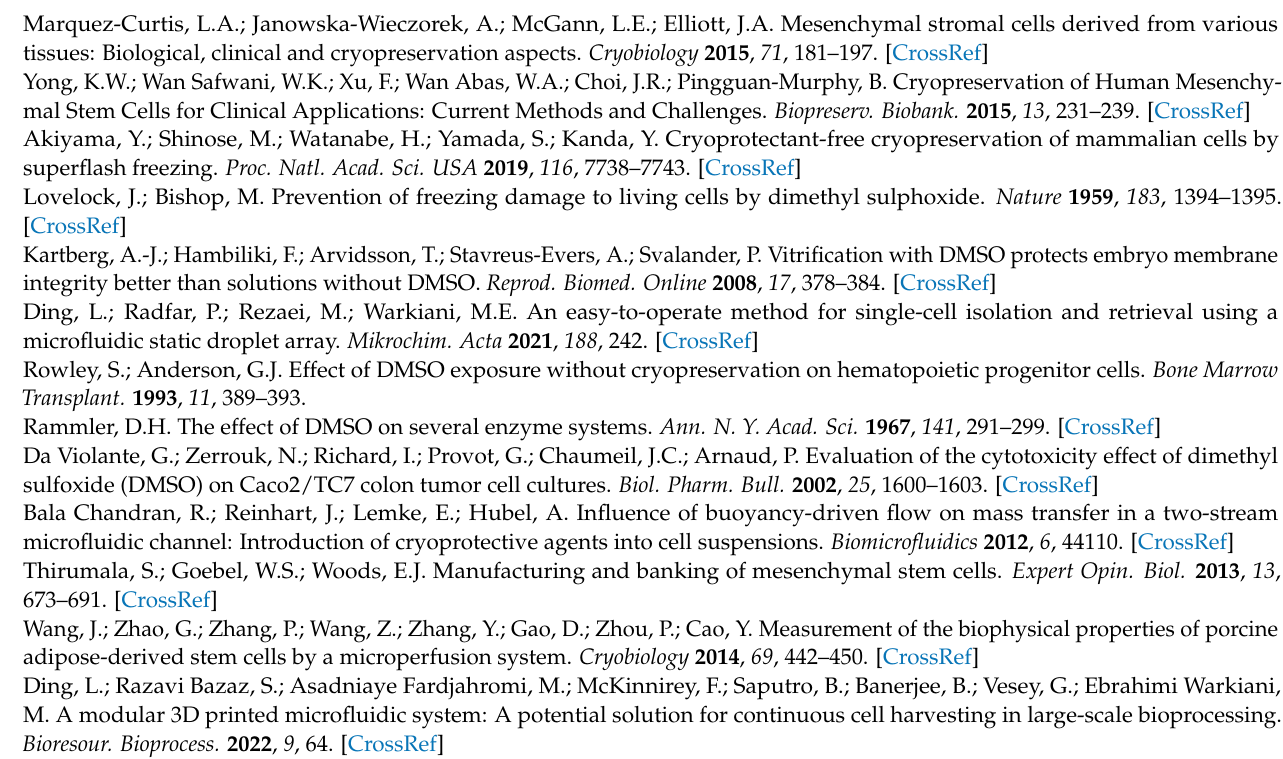
micromixer; Figure S2: The grid independence test; Figure S3: The results of food dye mixing with DI water characterise the mixing efficiency of the micromixer in a real case; Figure S4: Characterisation of cytoplasmic dye concentration before using it for a mixing experiment; Figure S5: The micromixer mixing group and manual mixing group control cells after 15 min of